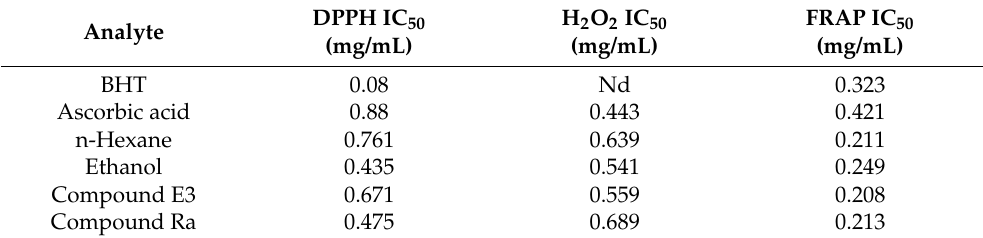
Table 4. IC 50 values (mg/mL) of M. oleifera extracts and pure compounds in DPPH scavenging, hydrogen peroxide, and reducing power